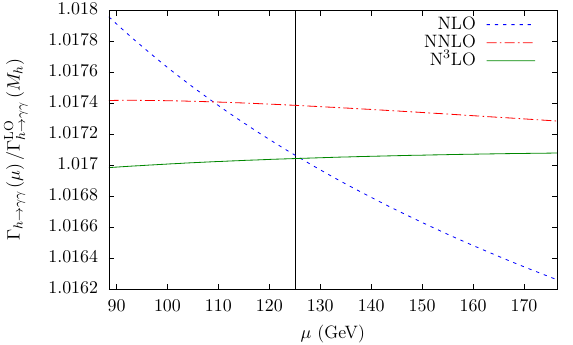
Figure 6: The scale dependence of the large- m N3LO corrections to Γ The vertical black line is at µ = m